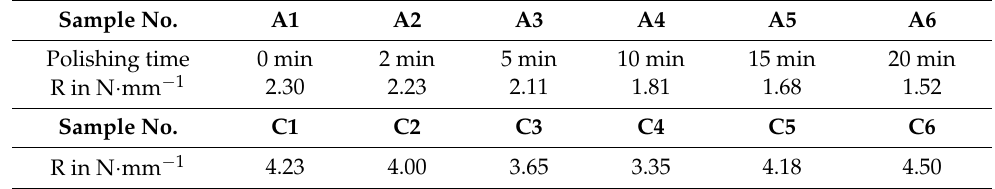
Table 5. Calculated spring rates R for all measured